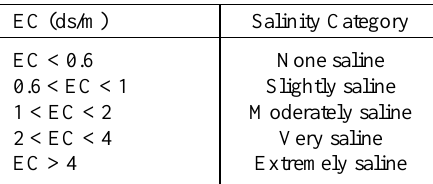
Table 1 . Salinity classes were introduced by Durand (Durand,